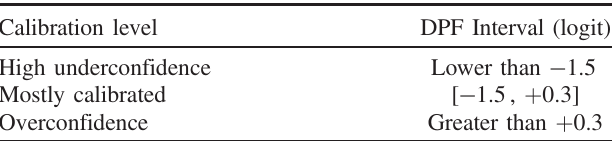
TABLE II. Final adopted intervals of differential persons functioning (DPF) measures of